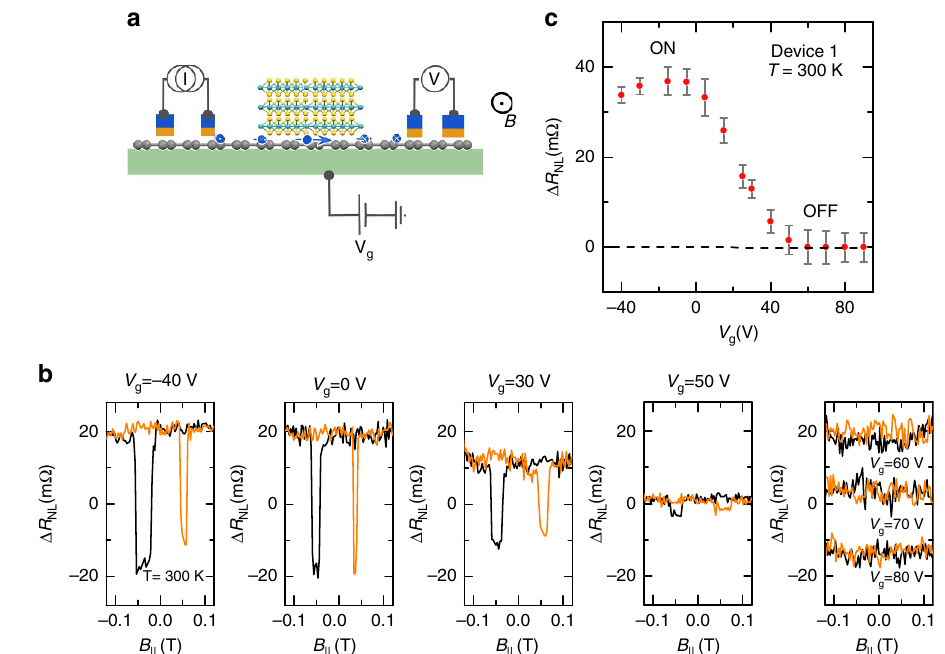
Figure 2 | Gate-controlled spin valve signal at room temperature. ( a ) Schematic of the NL spin-valve measurement geometry, where the spin current injector circuit (I) and the voltage detector circuit (V) are placed in a NL geometry. The spin current diffusing in the heterostructure channel is detected as a voltage signal by the FM detector. The magnetization of the injector/detector FM contact and also the sign of spin accumulation are controlled by an in-plane magnetic field B || . ( b ) NL spin-valve magnetoresistance D R NL ¼ D V NL = I ð Þ measurements at 300K by application of different gate voltages V g . Measurements are performed at a constant current source of I ¼ 30 m A. A NL linear background (few m V) due to stray charge current is subtracted from the signal. ( c ) Modulation of spin-valve signal magnitude D R NL with gate voltage V g , showing ON/OFF states at 300K. The error bar is derived from the root mean square of the noise in the measured